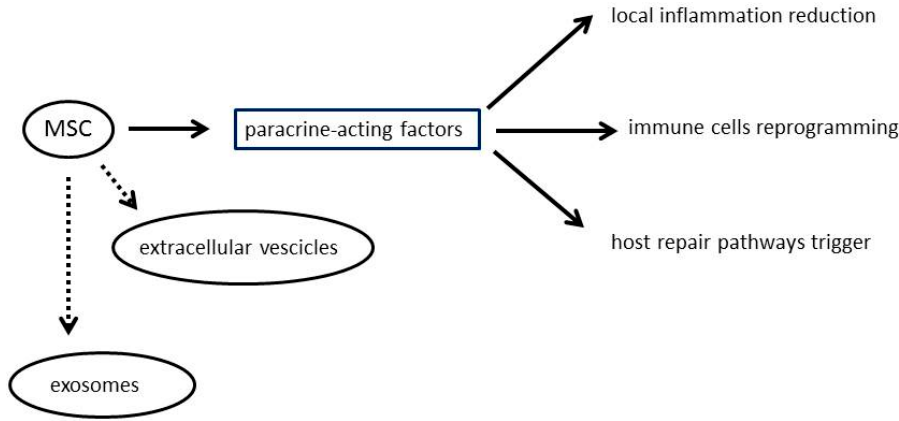
Figure 1. Potential mechanisms of mesenchymal stromal cells (MSC) actions.